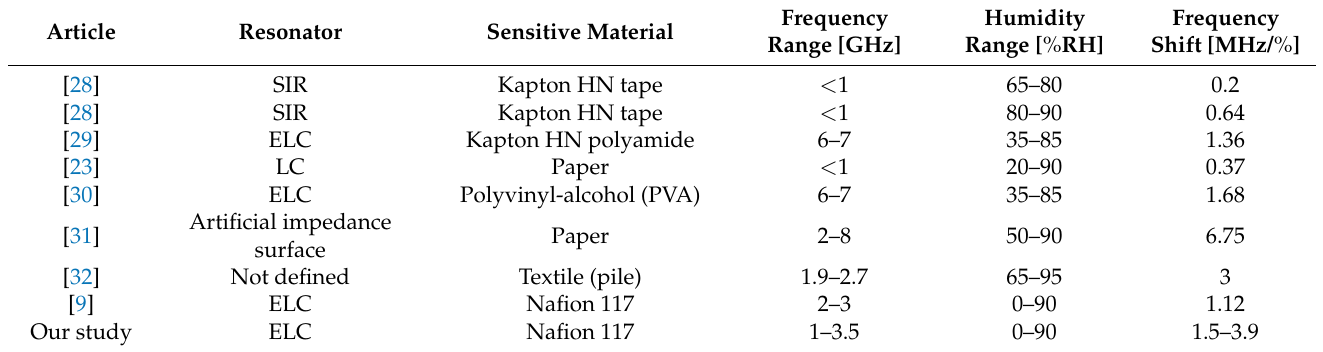
Table 1. Performance comparison of chipless humidity sensors from the literature expressed in terms of frequency shift.